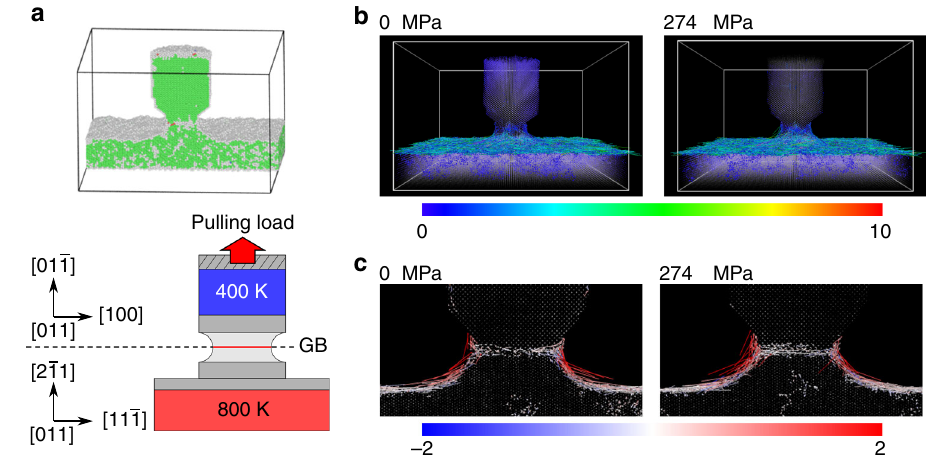
Fig. 5 Molecular dynamics (MD) simulation of atomic diffusion on an Al nanowire surface. a (Top) Simulation supercell of necking nanowire with asymmetric tilt grain boundary (GB) on the substrate. Atoms are colored by common neighbor analysis. The green, red, white atoms indicate the face- centered cubic structure, hexagonal close-packed structure, unknown coordination structure, respectively. (Bottom) Schematic diagram of the simulation with temperature gradient. The height of the intermediate region between red and blue regions is 6.3 nm. b Atomic displacement vector in the unit of nm after 10 ns MD simulation. The atomic displacement vector is colored by the magnitude of displacement. c Cross-section view of atomic displacement vector. The atomic displacement vector is colored by axial component. Red and blue arrows indicate the atoms moving upward and downward. Length of displacement vectors is reduced by half of the actual length. The MD results were visualized using OVITO